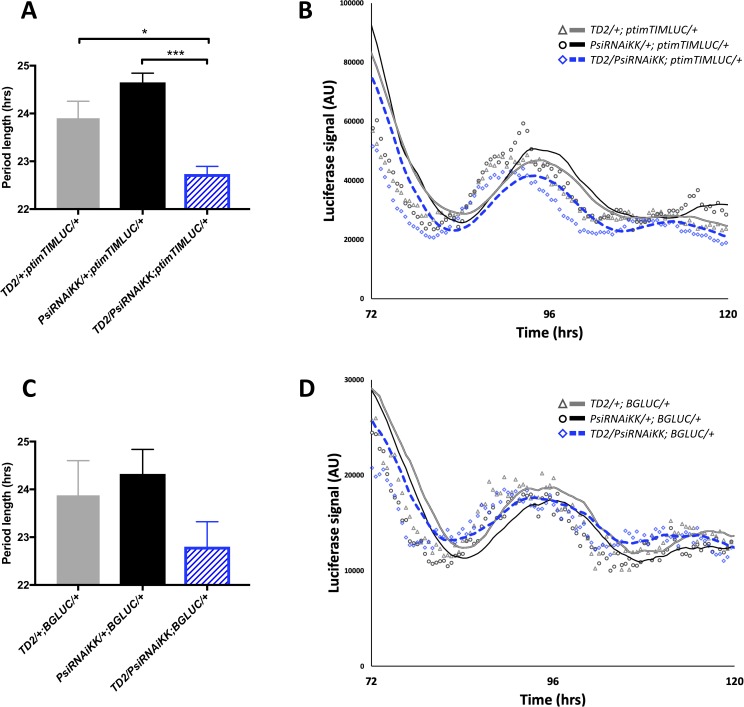
Knockdown of Psi shortens circadian period of PER and TIM rhythms in peripheral tissues.(A) Period length (hrs) of light output generated from luciferase rhythms of ptim-TIM-LUC in whole flies. 9–24 wells/run (with one exception for control genotype PsiRNAiKK/+; ptimTIMLUC/+), three flies/well. N = 6 runs. *p<0.05, ***p<0.001, one-way ANOVA followed by Tukey’s multiple comparison test. Error bars represent SEM. Gray bar: driver control. Black bar: RNAi control. Blue patterned bar: Psi knockdown. (B) Representative traces from (A) Markers are raw data and lines are 6 hr moving averages. Gray marker (triangle) and gray line: driver control. Black marker (circle) and black line: RNAi control. Blue marker (diamond) and blue dashed line: Psi knockdown. Luciferase signal (arbitrary units, AU) on the y axis and time (hrs) from start of experiment on the x axis. 72 hr = start of DD. (C) Period length (hrs) of average light output generated from luciferase rhythms of BG-LUC in whole flies. 12–30 wells/run, three flies/well. N = 4 runs. Error bars represent SEM. Gray bar: driver control. Black bar: RNAi control. Blue patterned bar: Psi knockdown. (D) Representative traces from (C) Markers are raw data and lines are 6 hr moving averages. Gray marker (triangle) and gray line: driver control. Black marker (circle) and black line: RNAi control. Blue marker (diamond) and blue dashed line: Psi knockdown. Luciferase signal (arbitrary units, AU) on the y axis and time (hrs) from start of experiment on the x axis. 72 hr = start of DD.Figure 2—figure supplement 2—source data 1.TIMLUC signal.Figure 2—figure supplement 2—source data 2.BGLUC signal.Figure 2—figure supplement 2—source data 3.Figure statistics – Figure 2—figure supplement 2.